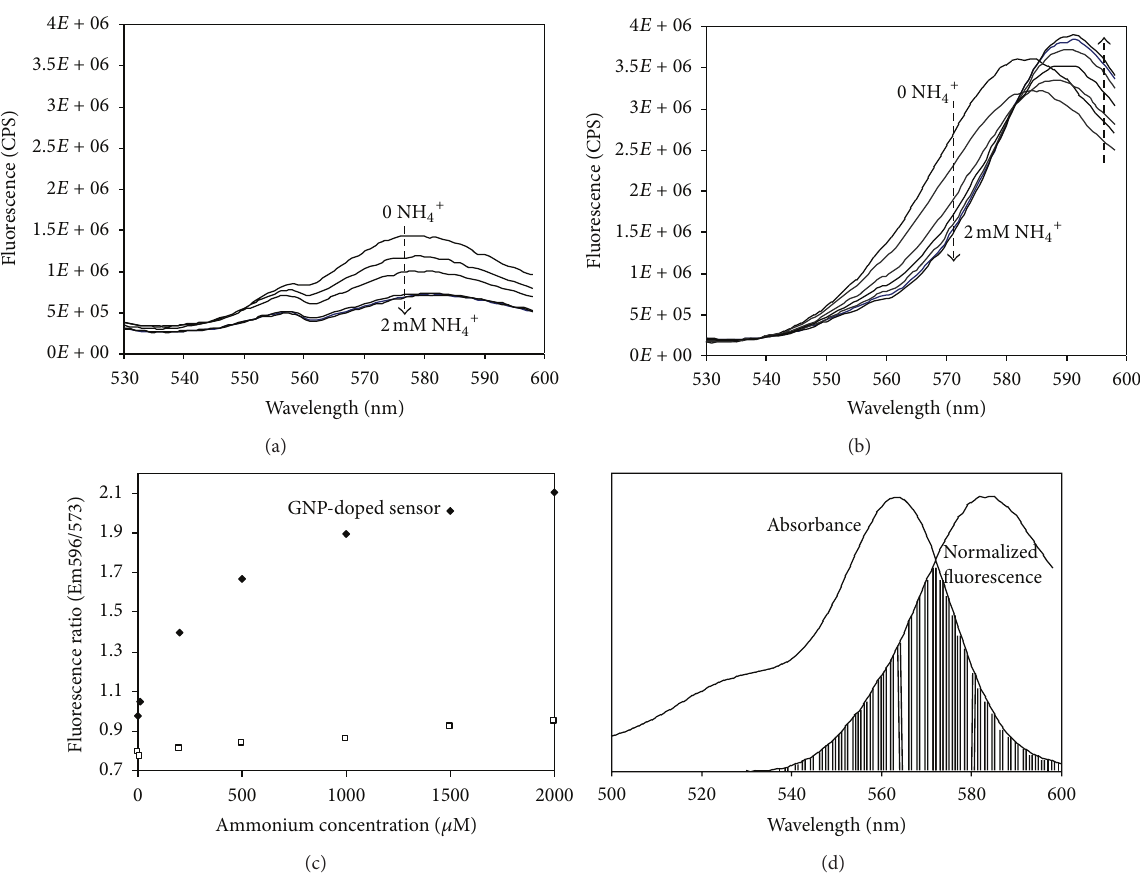
Figure 3: MC540 fluorescence at 511nm excitation for an ammonium (concentrations 0, 10, 200, 500, 1000, 1500, and 2000 𝜇 M) sensor without (a) and with (b) nanoparticles. (c) Calibration curves for sensors without ( ◻ ) and with nanoparticles ( ⧫ ). (d) Acceptor absorbance, donor fluorescence, and the FRET overlap peaking at 572.5